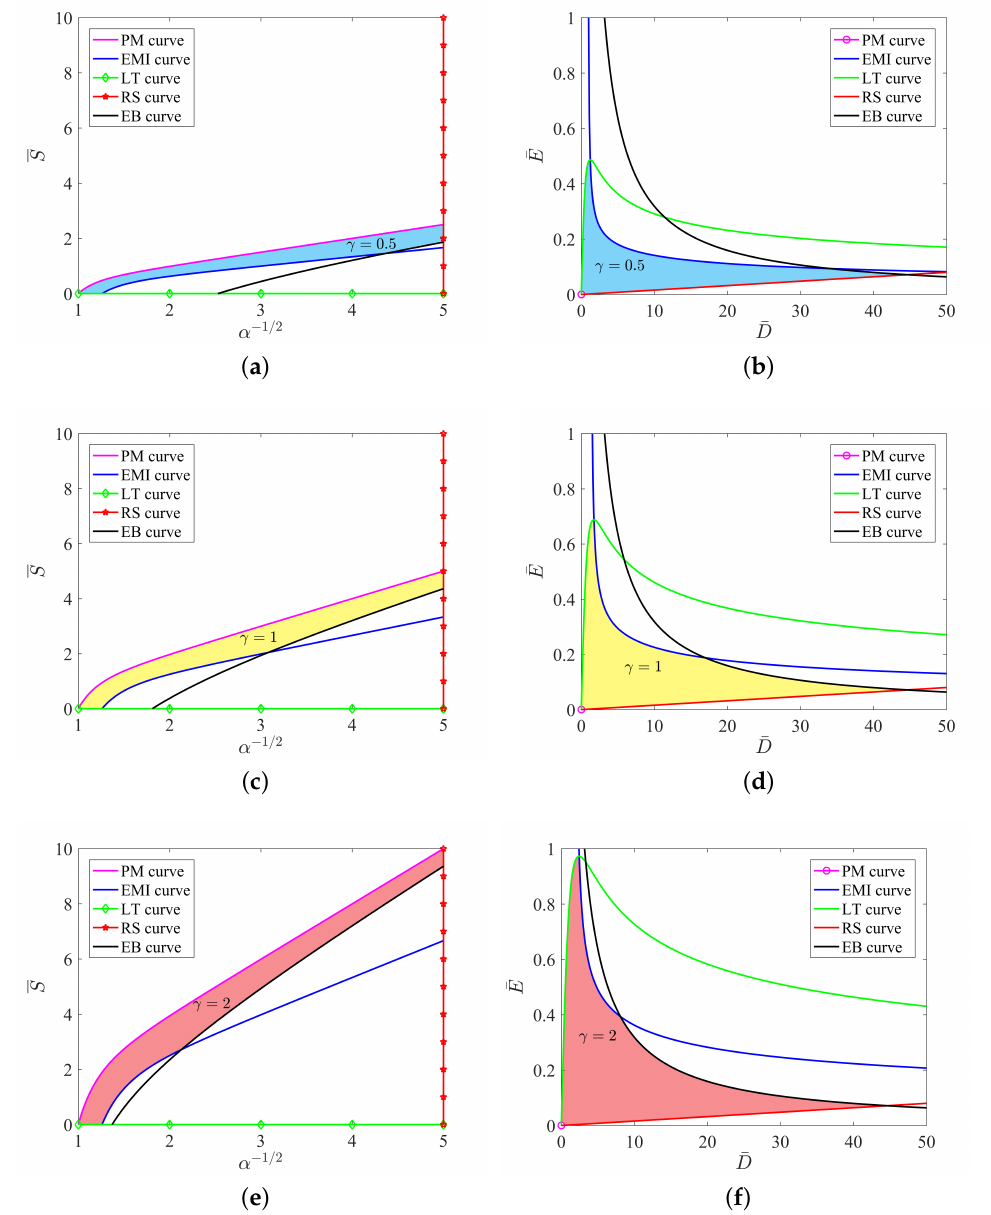
Figure 4. Five curves on the stress ¯ S vs. stretch λ = α − 1/2 plane and the dimensionless electric field ¯ E vs. ¯ D plane under different ratios γ = 0.5,1,2. The shaded area in each figure is the maximum specific energy that can be harvested. γ = 0.5 in ( a , b ), γ = 1 in ( c , d ), γ = 2 in ( e , f